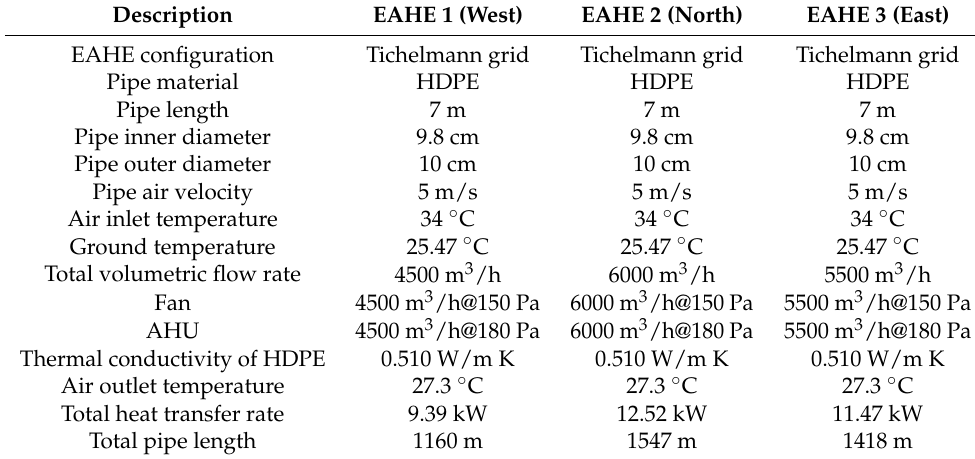
Table 4. Specifications and boundary conditions of EAHEs. Legend: HDPE—high-density polyethy- lene; AHU—air-handling